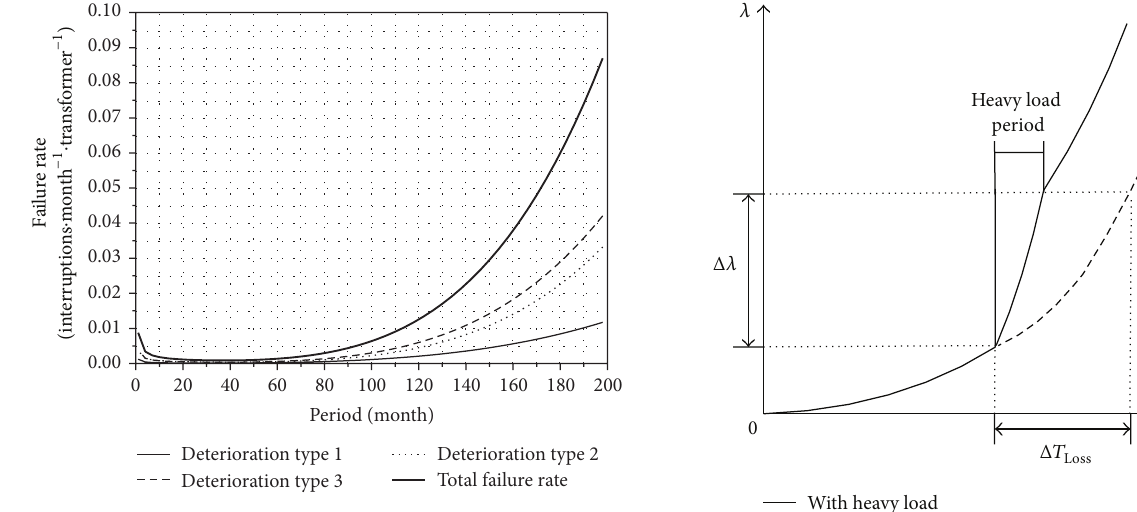
Figure 1: An example of decoupled failure rate curves.